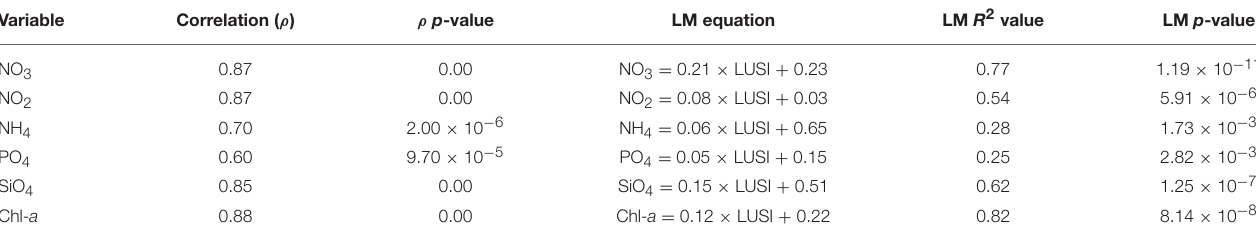
TABLE 5 | Relationships between LUSI values calculated using the 2009 Mapa de Cobertes del Sòl de Catalunya and dissolved inorganic nutrient concentrations [log-transformed 90th percentiles of nitrate (NO 3 ), nitrite (NO 2 ), ammonium (NH 4 ), phosphate (PO 4 ), and silicate (SiO 4 ), in µ M] or chlorophyll- a (Chl- a ; log-transformed 90th percentiles in µ g/L), measured between 2007 and 2012 at water bodies along the Catalan